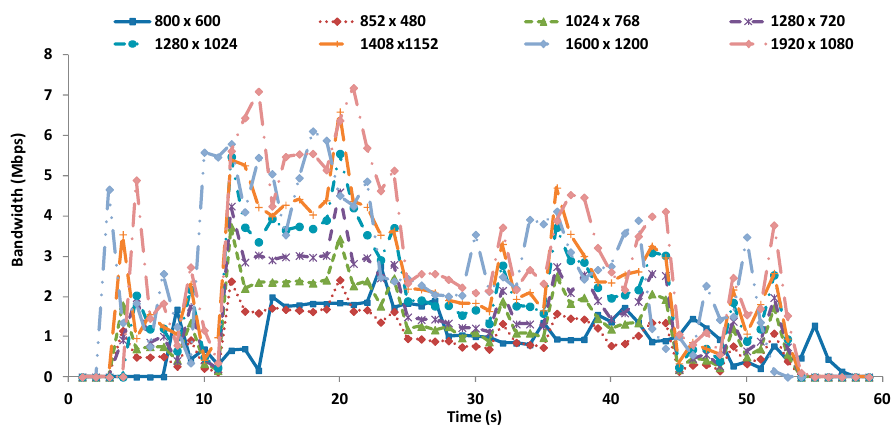
Figure 3. Bandwidth for videos at 30 fps.